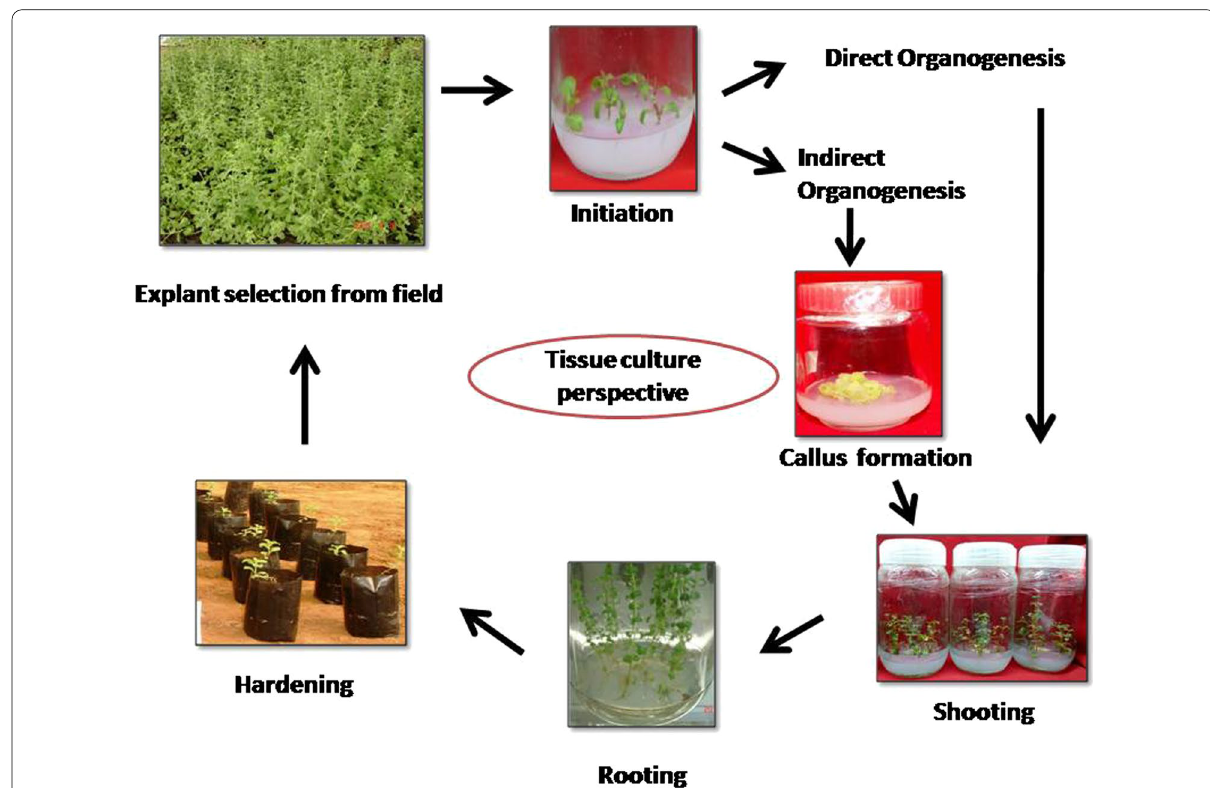
Fig. 3 Overview of plant tissue culture